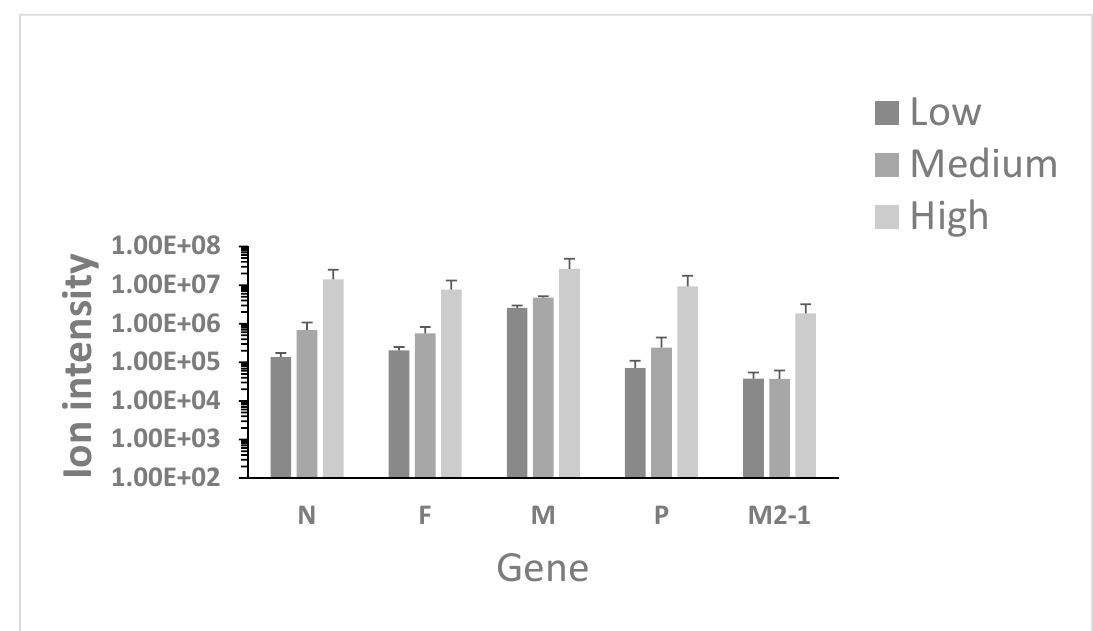
Figure 1. Analysis of summed peptide intensities of Human respiratory syncytial virus (HRSV) proteins identified and quantified in the nasopharyngeal aspirates from children with different viral loads of HRSV, as determined by Ct, low viral load (Ct > 25), medium viral load (Ct = 20–25), and high viral load (Ct < 20).